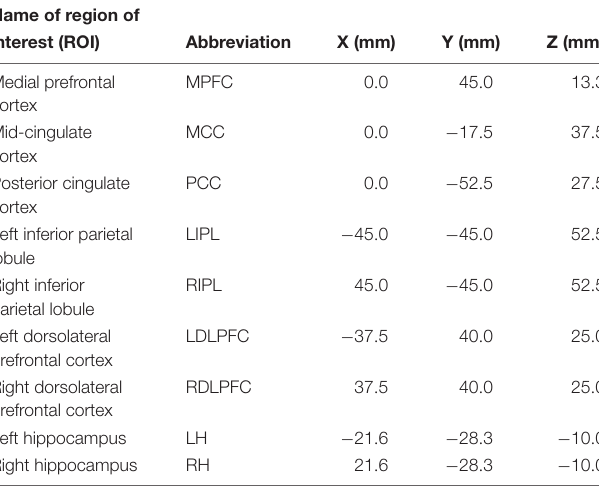
Dots in Figure 1 represent the statistical comparison between the conditions, i.e., the changes that occurred after SOn. Gray dots indicate frequency bins at which effective connectivity was enhanced after SOn, black dots those at which it was